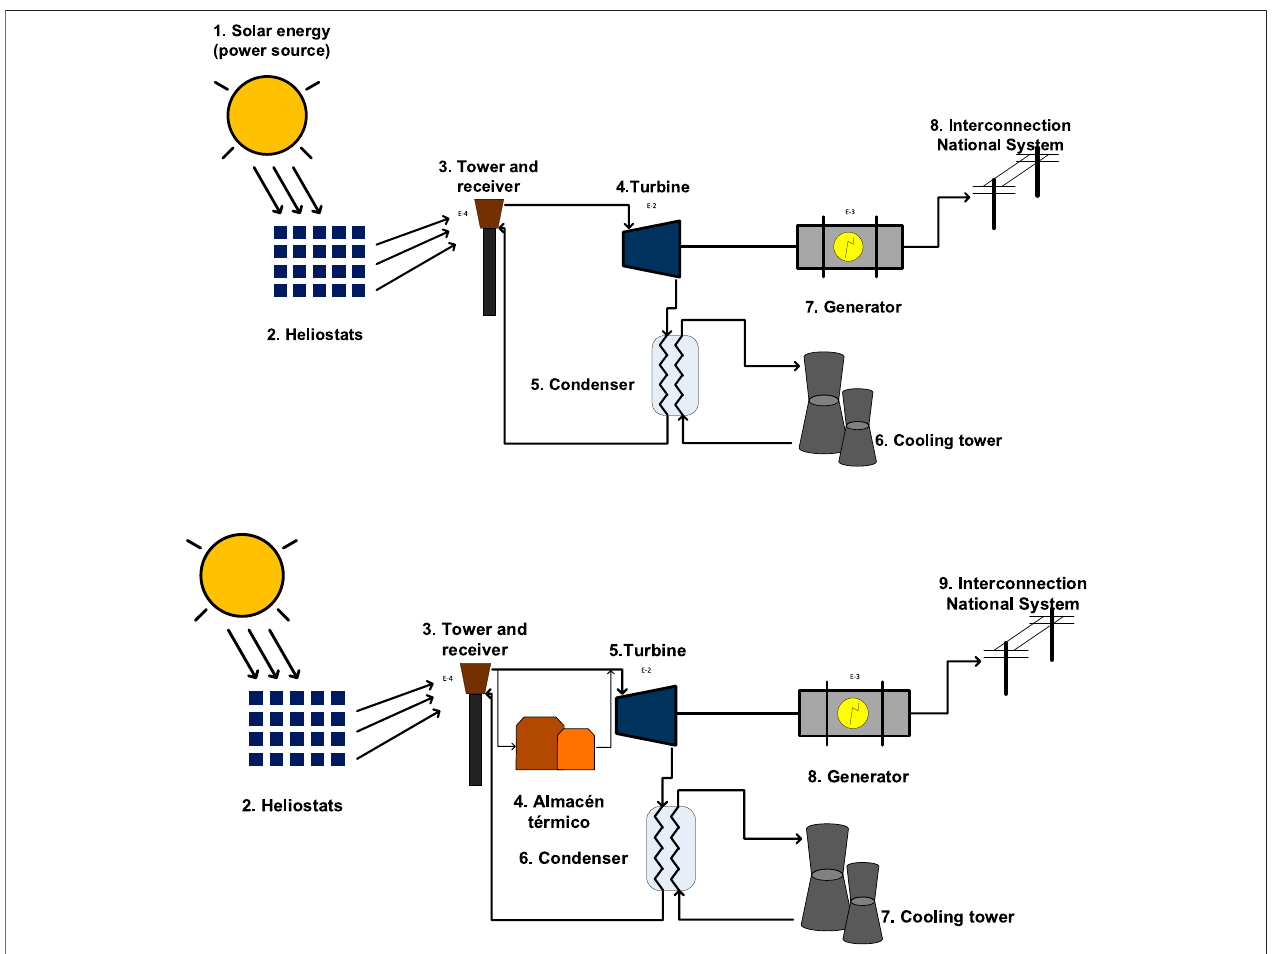
FIGURE 1 | Stages in the generation of electrical energy through solar concentrators, with and without thermal storage systems.